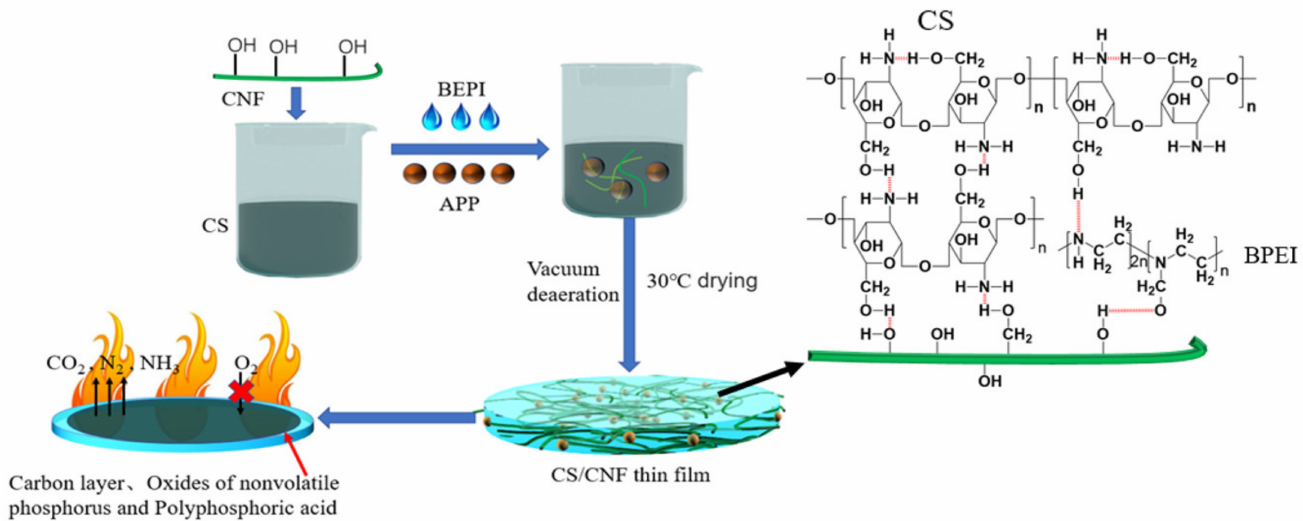
Figure 1. Formation mechanism of CS-based composite